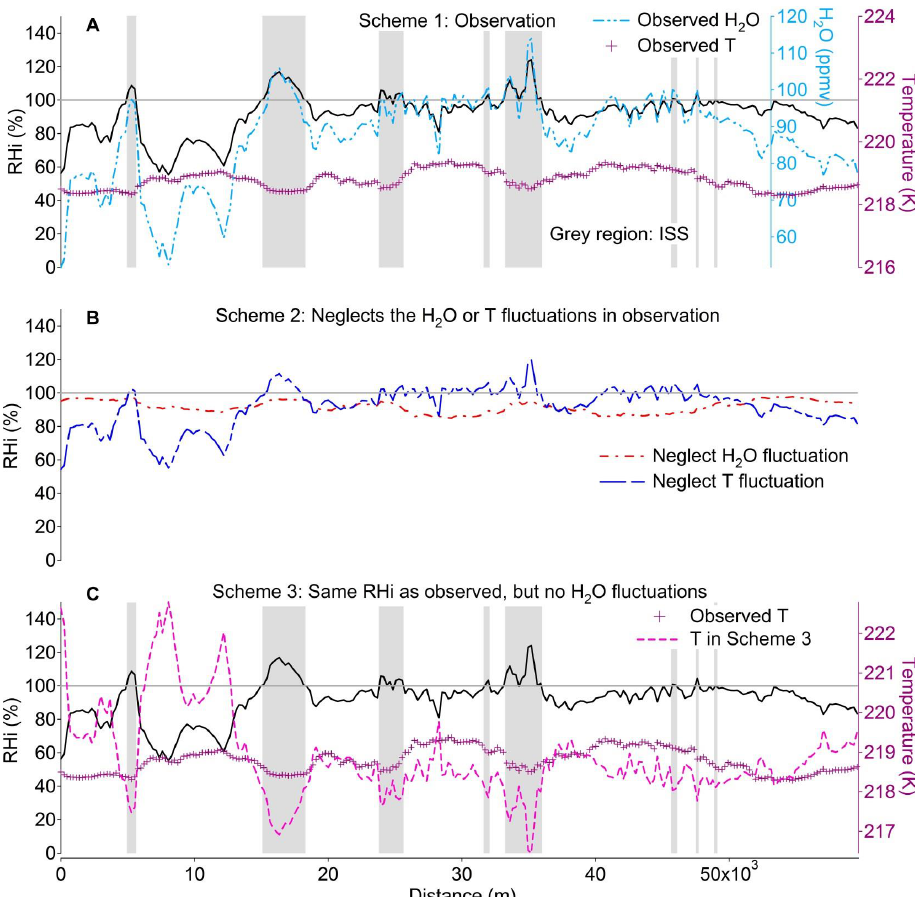
Fig. 13. Example of derivations of ISS spatial variability on a horizontal layer. The horizontal grey solid line denotes RHi=100% and grey regions in (A) and (C) represent ISSRs. (A) Scheme 1 is an example of the horizontal distribution of RHi (black line), T (purple cross) and H 2 O (light-blue dashed line) from the observation. (B) Scheme 2 either neglects H 2 O variability or T variability from the observation. The red short dashed line (blue long dashed line) uses the same T (H 2 O) variability as observed, but neglects H 2 O ( T ) fluctuations and only considers the mean H 2 O ( T ) value. The result gives no ISS when neglecting H 2 O fluctuations. (C) Scheme 3 uses T fluctuations to generate the same RHi distribution as observed, but still neglects H 2 O fluctuations. The result implies lower T values in ISSRs (pink dashed line) than the observed T values (purple